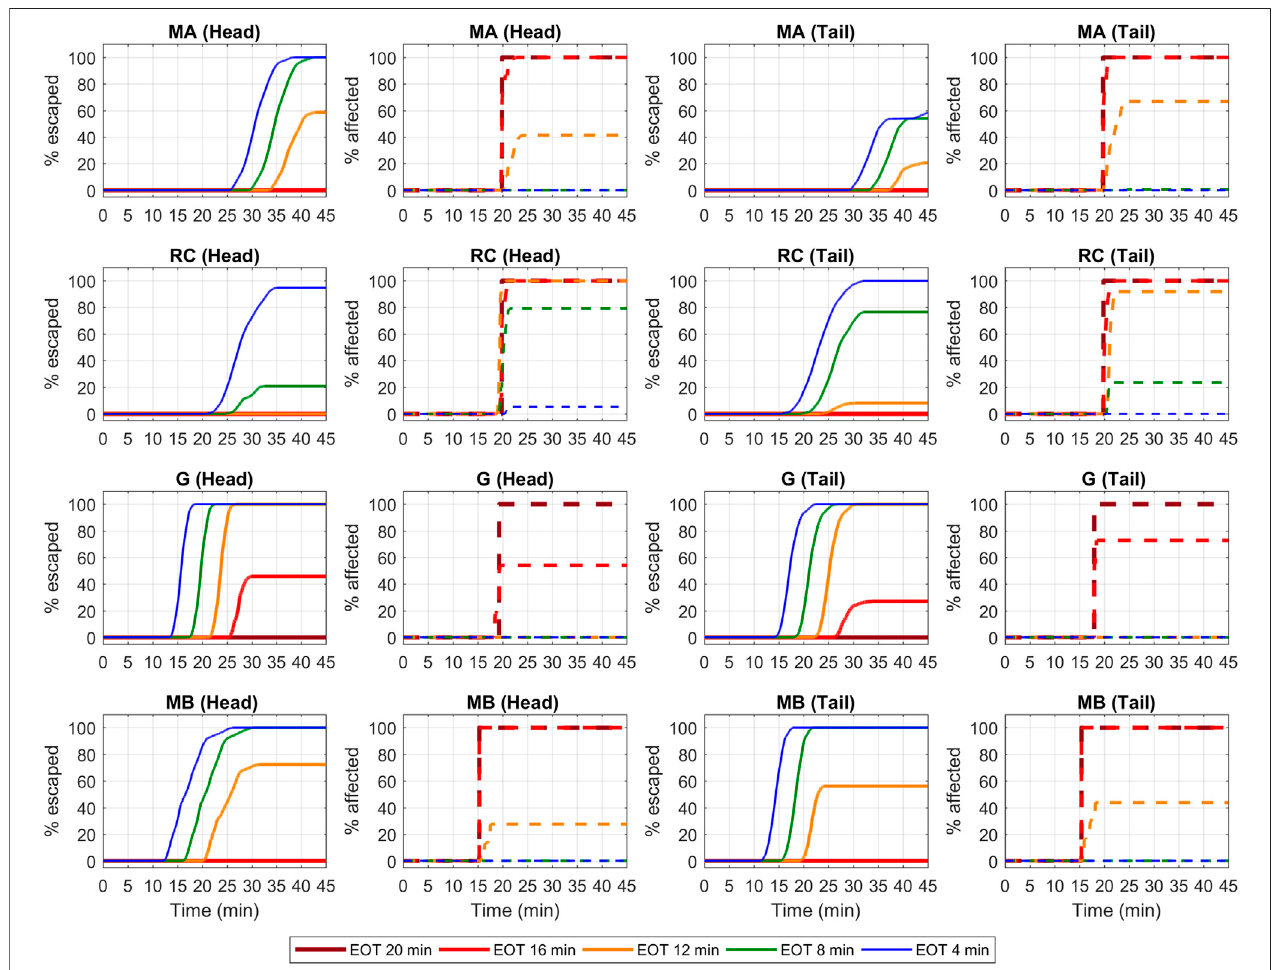
FIGURE 6 | Evacuation curves of the four examined schools (EOT (cid:1) 4, 8, 12, 16, and 20 min.